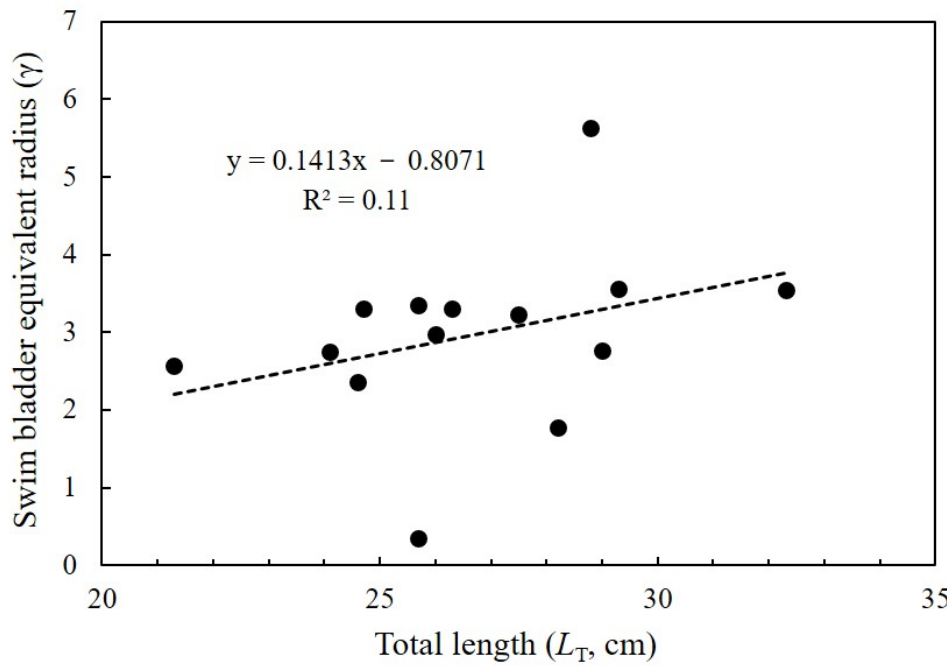
Figure 4. The relationship between Pacific herring L T and the swim bladder equivalent radius (r). Studies have shown that the herring swim bladder is affected by the body fat composi- tion and gonad size [25,26]. The relationship between the swim bladder equivalent radius and gonad somatic index (GSI) is presented in Figure 5. GSI is calculated as GSI = gonad weight × 100/(weight–gonad weight). The swim bladder equivalent radius decreased as GSI increased, but the correlation was